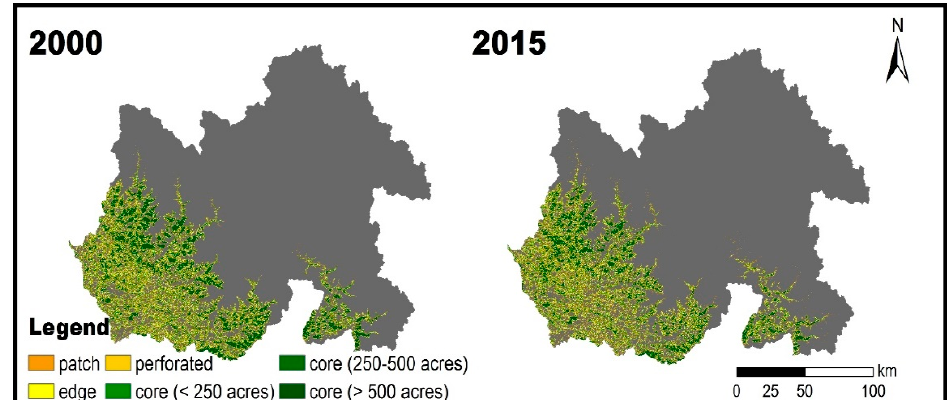
Figure 4. Forest fragmentation maps from 2000 and 2015. Core—relatively distant from the forest– non-forest boundary; patch—forests too small to be considered as core forest; perforated—boundaries between core forest and relatively small perforations; edge—boundaries of relatively large perforations and the exterior boundaries of core forest regions.